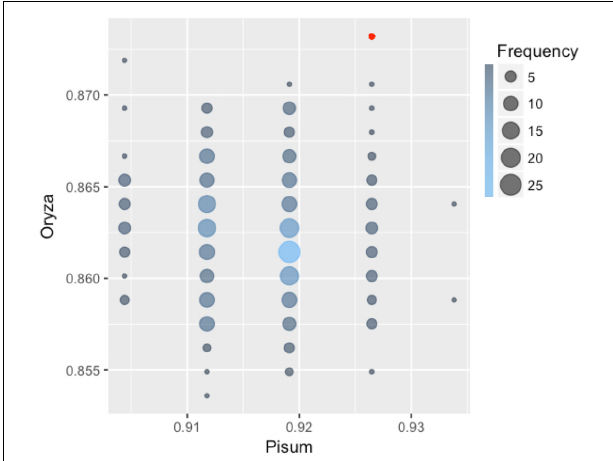
FIGURE 2 | Classification accuracy of 300 Random Forest classifiers learned on the Arabidopsis thaliana dataset and applied to classify mutations in pea and rice. Some of the 300 classifiers demonstrated the same values of accuracy on both Orýza sativa and Pisum sativum . Size and color of circles show frequencies of the classifiers with the same performance. The accuracy value for the best classifier is emphasized with red color.